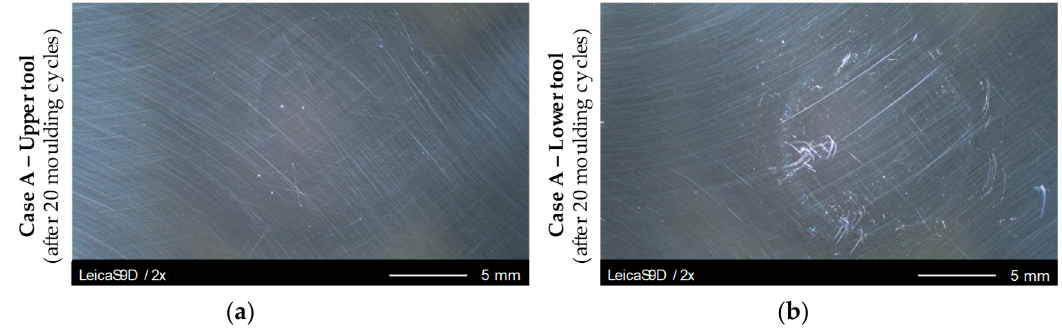
Figure 11. Light microscopic inspection of Case A moulding samples after 20 moulding cycles: ( a ) Case A—Upper tool; ( b ) Case A—Lower tool.